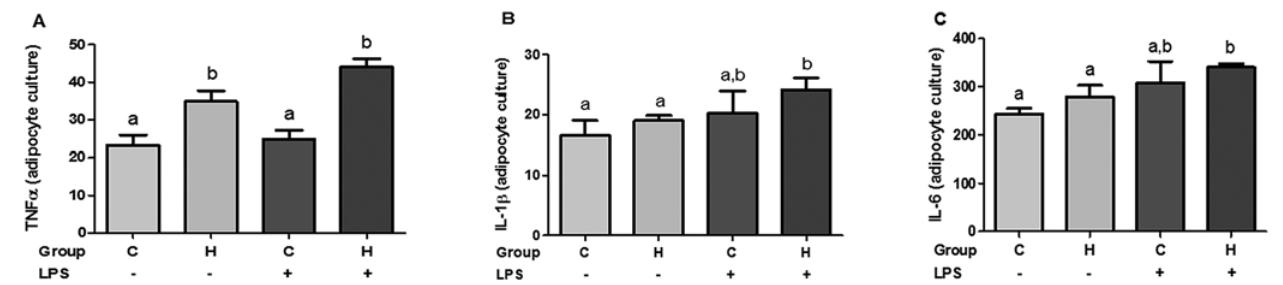
FIGURE 3 – Concentrations of TNFα (A), IL-1b (B) and IL-6 (C) in the adipocyte culture from mice fed with the C or H for 6 week and incubated with (+) or not (-) with LPS (1.25 pg/mL) for 2 h. Values are presented as mean and SD (n = 7/group). Bars without